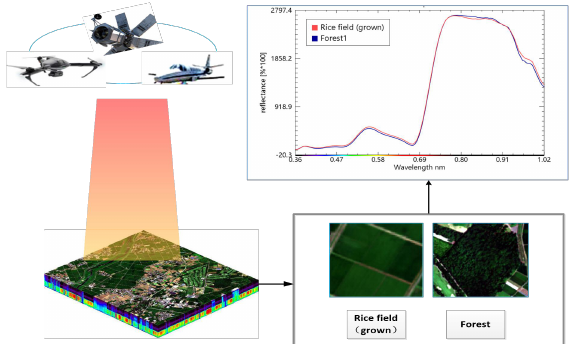
Figure 1 . Remote sensing image with high spectral resolution and high spatial